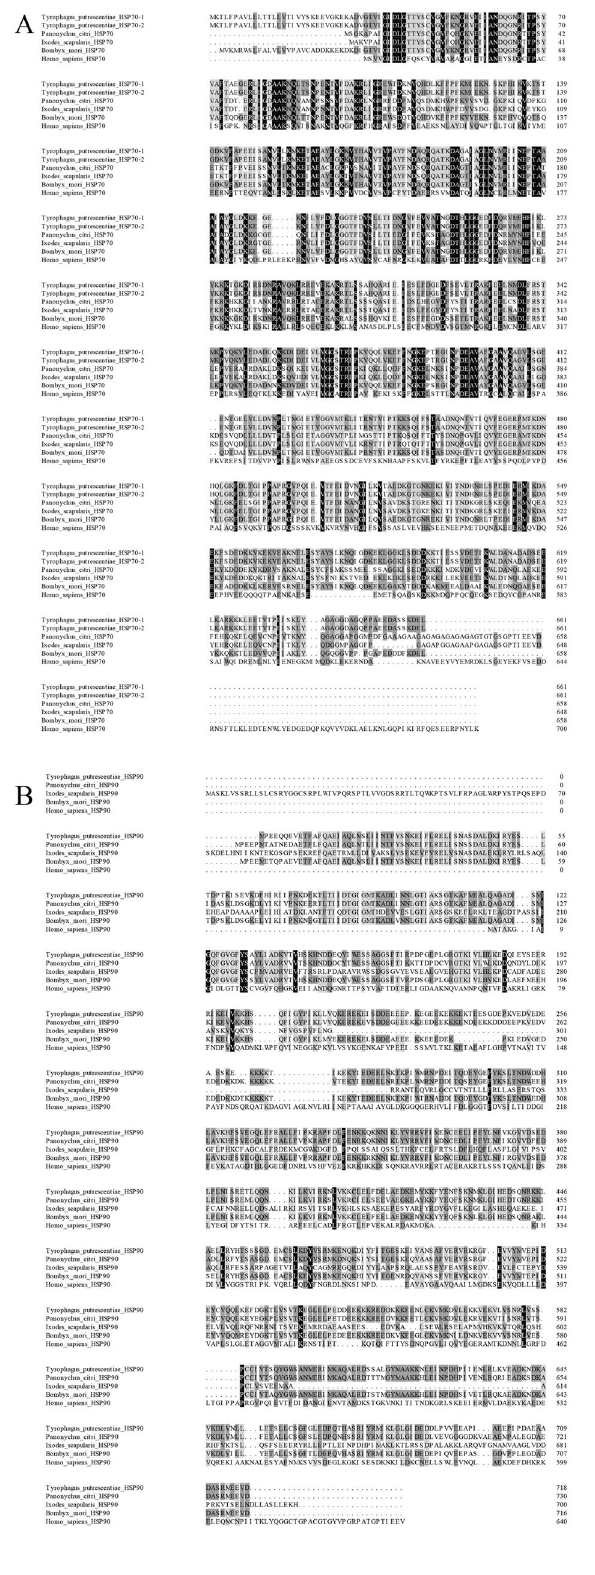
Figure 2. Comparison of the amino acid sequences of HSP70 protein family ( A ) and HSP90 protein family ( B